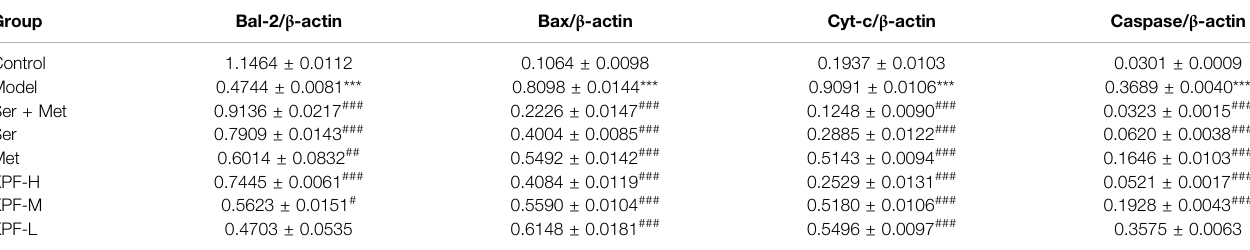
Values are expressed as the mean ± SD; n (cid:2) 3 in each group. Compared with control. *** P < 0.005, Compared with model, # P < 0.05, ## P < 0.01, ### P <